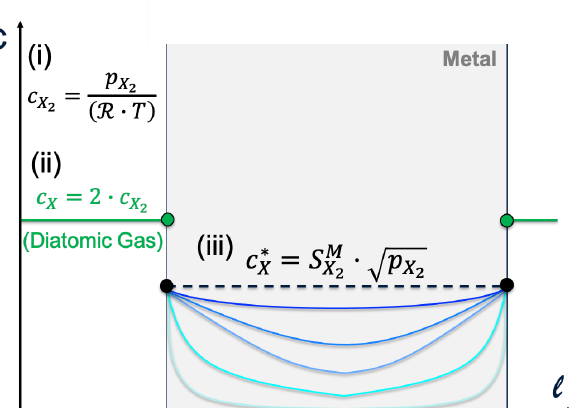
Figure 4. Diagram of BC determination at the gas-metal interface for a bulk-controlled single metallic barrier, when experiencing on both sides an infinite supply of diatomic gas at given temperature T and pressure p X . ( i ) Calculation of gas density ( c X ) at the metal surface with the ideal gas law. 2 2 ( ii ) Calculation of the surface atomic concentration ( c X , in green ) by multiplying the gas density by the number of atoms that compose the gas molecules, due to dissociation. ( iii ) The effective fixed BC applied is the minimum between the atomic concentration and Sieverts’ concentration ( c ∗ ) for that X gas pressure, obtained using Sieverts’ constant ( S M ). This BC leads to concentration profiles evolving X 2 in time (in blue , from light to dark). The particular case of c X > c ∗ is represented; in equilibrium, the X concentration inside the bulk tends to c ∗ (in black , X